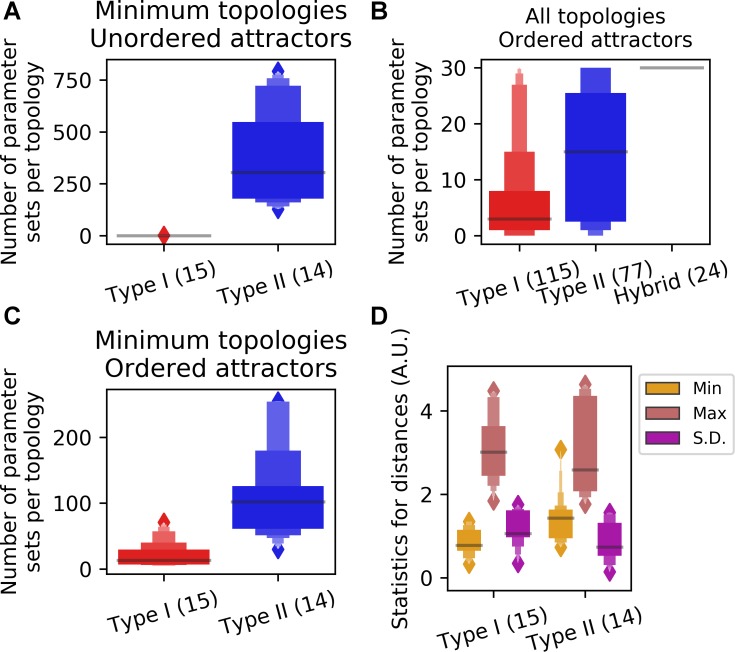
Comparison of Type I and Type II motifs for their performance in producing systems with four ordered attractors.A. The numbers of parameter sets per 106 samples per topology that generate four ordered attractors from two types of minimum motifs. B. The numbers of parameter sets per 106 samples per topology (limited to 30 per topology) that generate four ordered attractors from three types of motifs. C. The numbers of parameter sets per 106 samples per topology that generate four unordered attractors from two types of minimum motifs. D. Inter-attractor distances for each parameter set that generates four ordered attractors were calculated and summarized. For each set of parameters associated with the four attractors, the minimum, the maximum and the standard deviation of the distances were analyzed. Minimum Type I and Type II motifs were compared using these statistics.